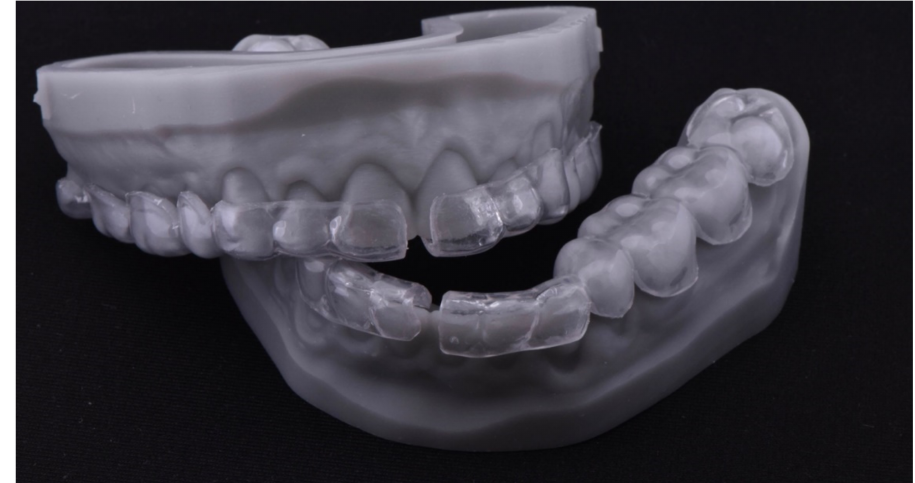
Figure 14. Heat forming hard trays.